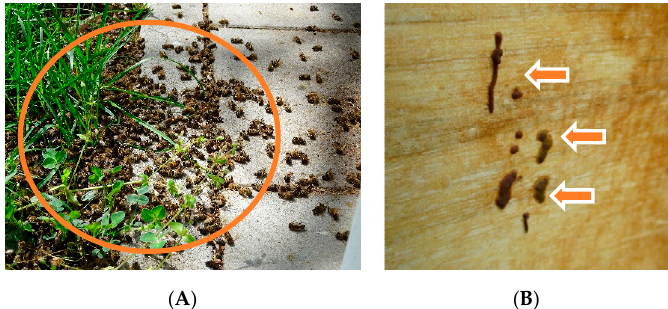
Figure 2. ( A ) Dead bees laying on the stone floor tiles and grass in front of the hive of colony 2 (orange circle), ©Julia Dittes. ( B ) Close-up of scattered brown feces found on the hive of colony 1 (orange arrows), ©Julia Dittes.